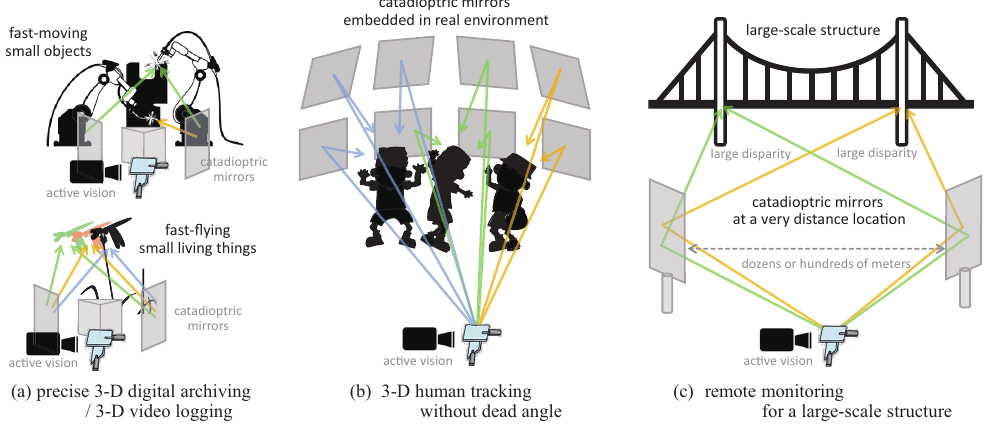
Figure 3. Configuration examples of catadioptric mirror systems, referring to practical applications of catadioptric stereo tracking: ( a ) precise 3-D digital archiving or 3-D video logging; ( b ) 3-D human tracking without dead angle; ( c ) remote monitoring for a large-scale